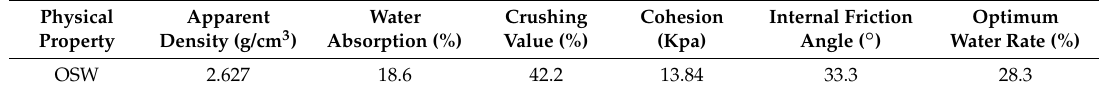
Table 2. Physical parameters of OSW.